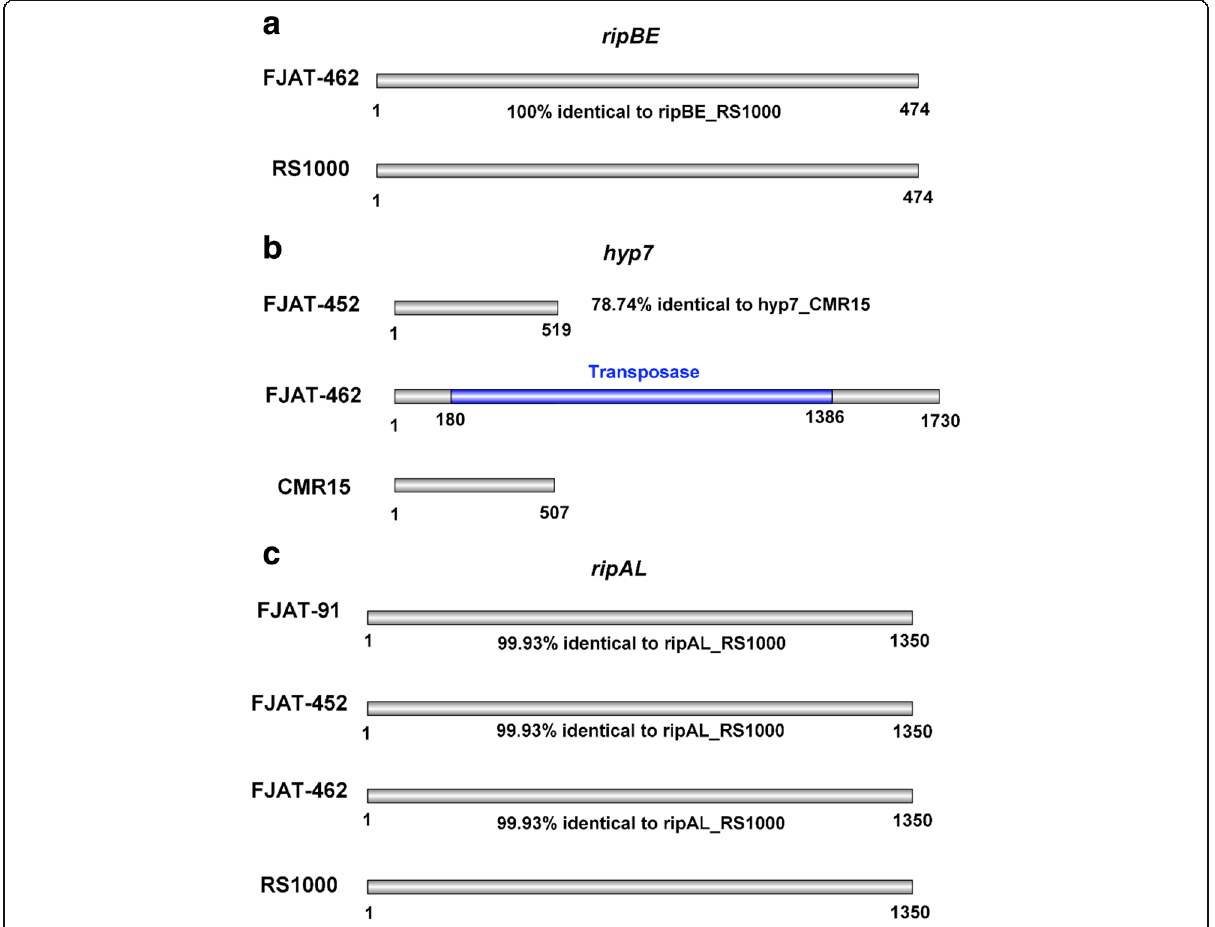
Fig. 3 Schematic diagram of ripBE ( a ), hyp7 ( b ) and ripAL ( c ) sequence alignment. The nucleotide sequence of these genes in the strains sequenced in this study is 100% identical to each other, except for hyp7 , which has an insertion annotated as a transposase in FJAT-462 (numbers indicate the insertion site). The percentage of identity compared to the orthologs in other sequenced strains is indicated in the figure